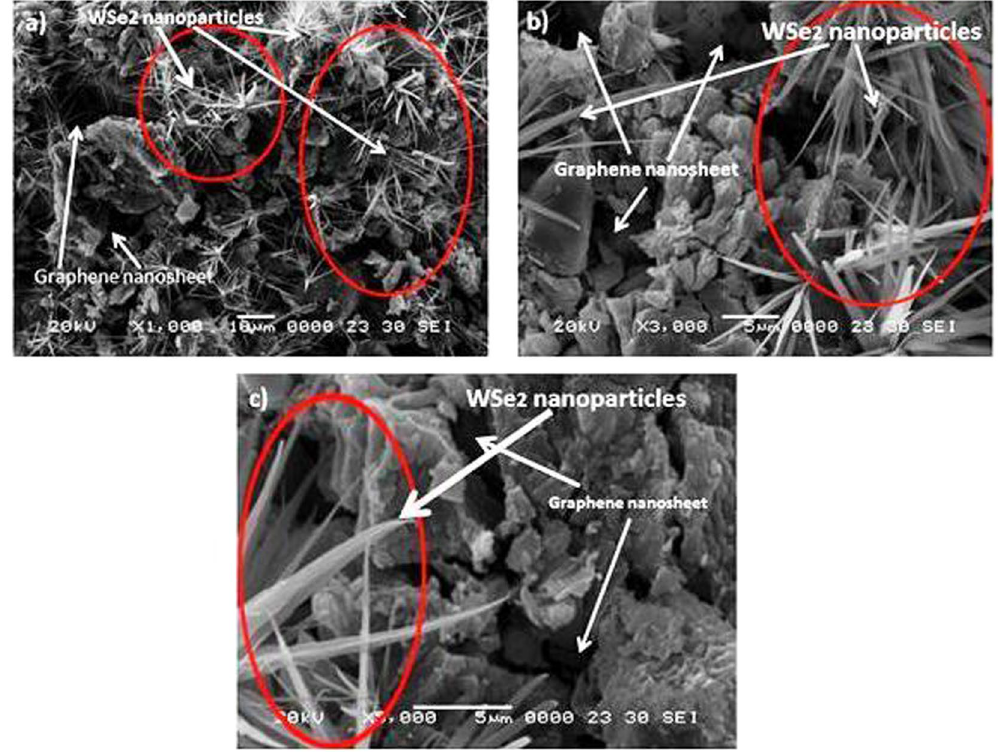
Figure 3. SEM imges of WSe 2 -graphene composite with different mignification.